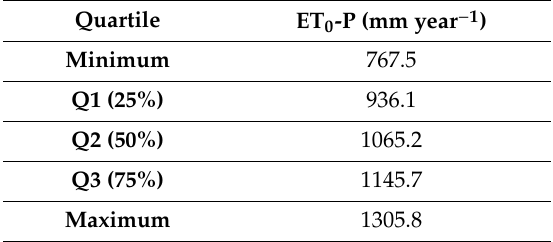
Table 3. Potential annual water deficit ET 0 -P 1992–2016: inter-quartile